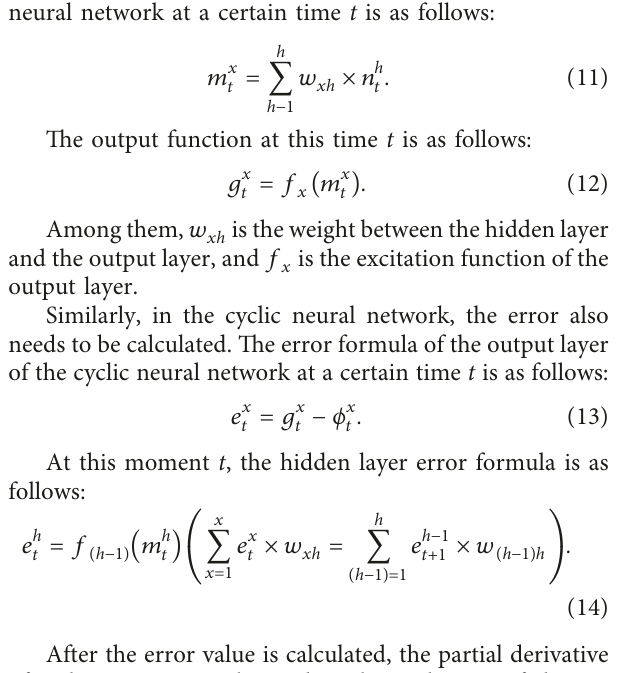
Figure 4: Simple neural network